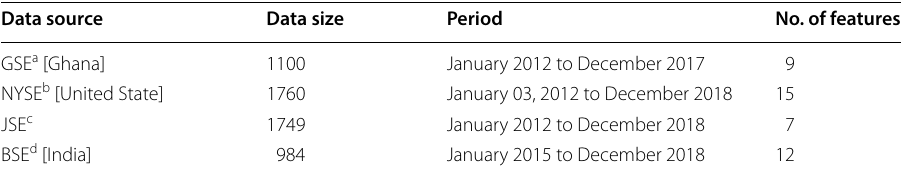
Table 2 Details of dataset